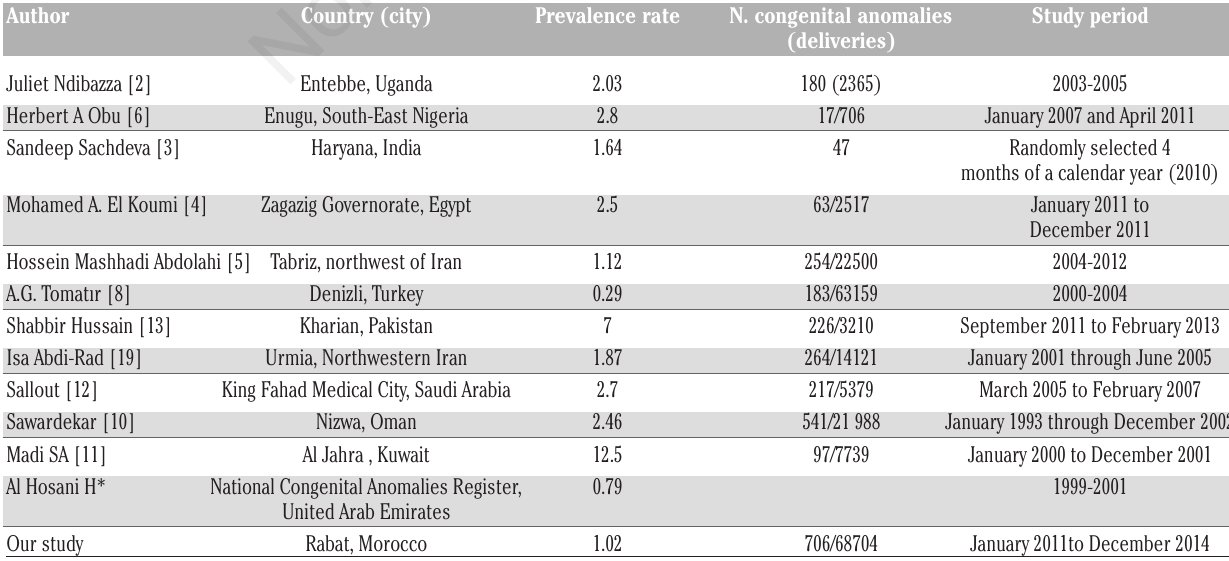
Table 4. Congenital malformations in other